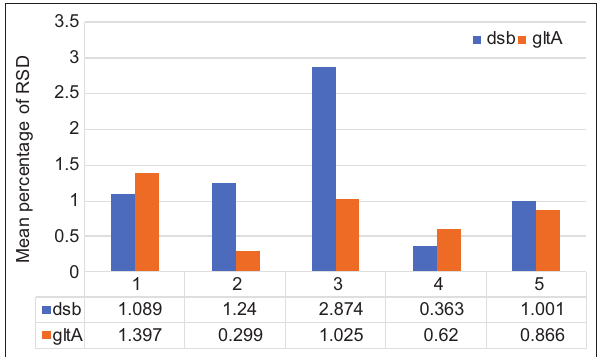
Figure-2: Comparison of the precision of real-time PCR on cloned E. canis targets (gene copy numbers ranged from 10 -3 to 10 -7 ) for dsb and gltA gene plasmid construct as measured using the percentage of relative standard deviation (RSD). The data show the average results from three separate runs. Table-3: Sensitivity of conventional and TaqMan real-time PCR. Plasmid 10-fold dilution